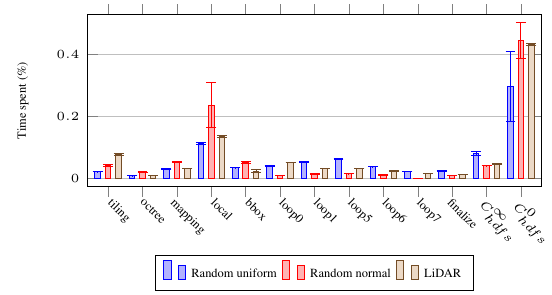
Figure 8. Percentage of time spend on the main step on 3 data sets (in average). Some intermediate iterations are not shown for visibility